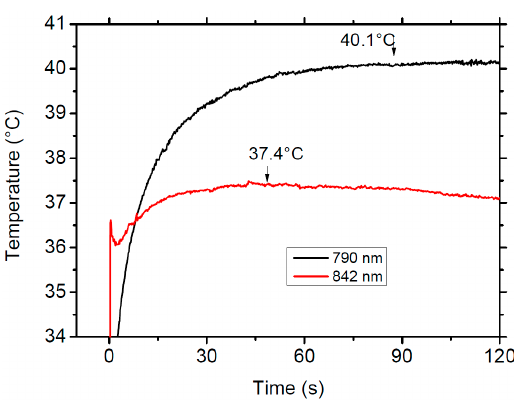
Figure 11. Comparison of the thermal response of the sample when excited at 790 nm, in the Stokes side (black line) of the absorption spectrum and in the cooling region, at 842 nm (red line), under the same experimental conditions with a power of 700 mW.